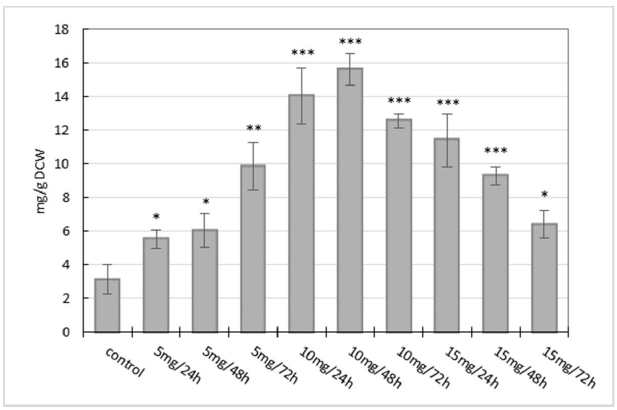
Figure 2. Time- and dose-dependent course of macarpine production in cell suspension cultures of California poppy after MnCl 2 treatment. Values are means ± S.D from triplicate experiments ( n = 3). * p ≤0.05, ** p ≤0.01, *** p ≤0.001.